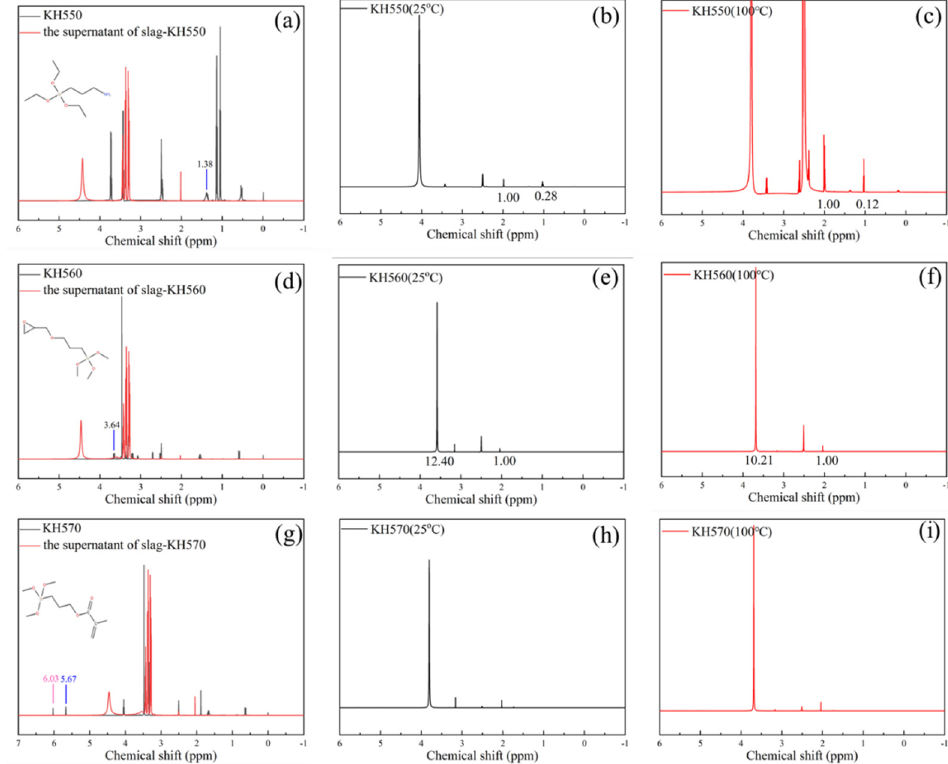
Figure 8. ( a – i ) Liquid-state 1 H NMR spectrum of ( a ) KH550; ( b ) KH550 (25 ◦ C); ( c ) KH550 (100 ◦ C); ( d ) KH560; ( e ) KH560 (25 ◦ C); ( f ) KH560 (100 ◦ C); ( g ). PVA; ( h ) KH570 (25 ◦ C); ( i ) KH570 (100 ◦ C).